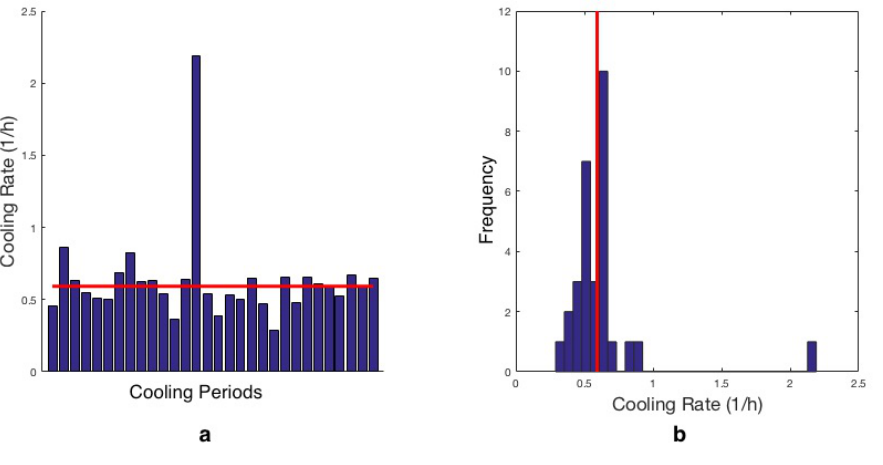
Figure 6. (a ) calculated values of cooling rate ( µ ) for different cooling periods for a sample house; ( b ) the histogram of calculated values of cooling rate ( µ